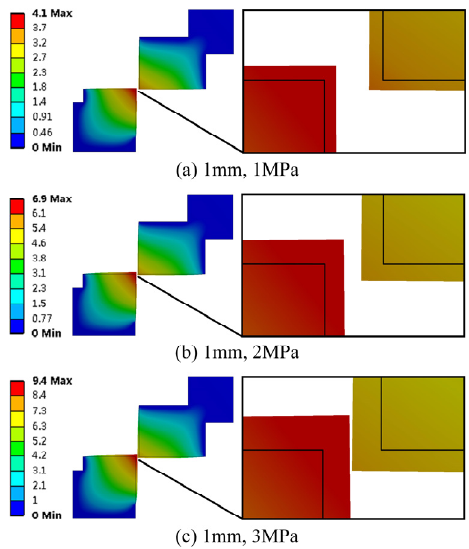
Figure 15. Thermal deformation at different inlet pressures, valve opening of 1 mm and with time at 60 min (magnified 30 times).